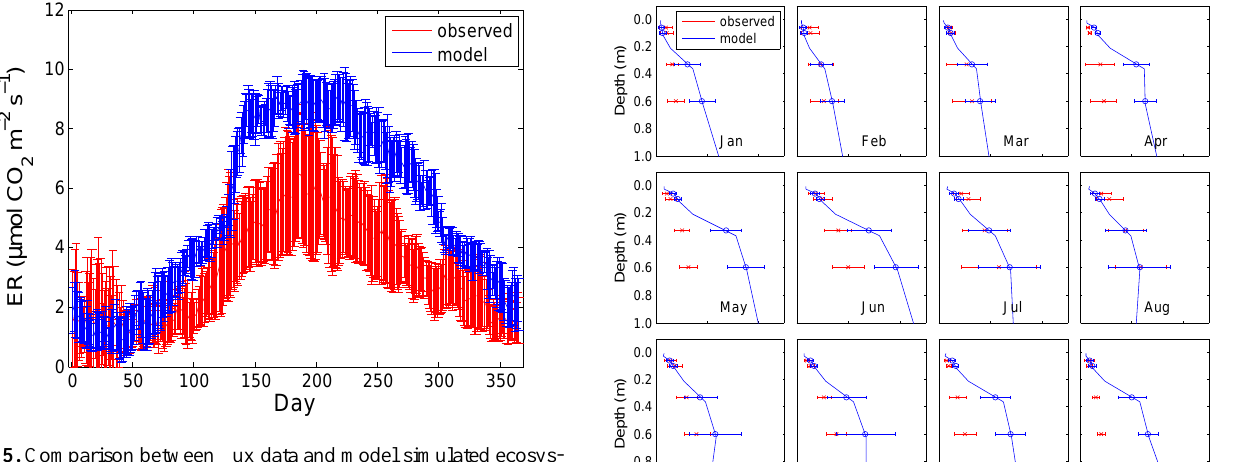
Fig. 5. Comparison between flux data and model simulated ecosys- tem respiration at the Harvard Forest site. The error bars indicate the one-standard deviation with respect to the mean. The observed data is derived from the level 4 eddy flux data at the site.